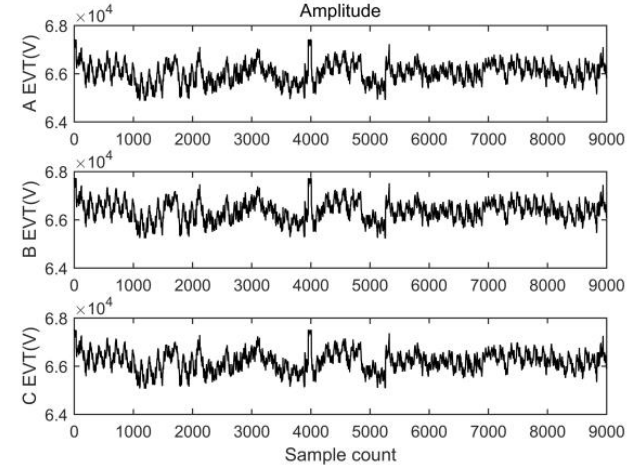
Figure 5. Collected measured data of the EVT.